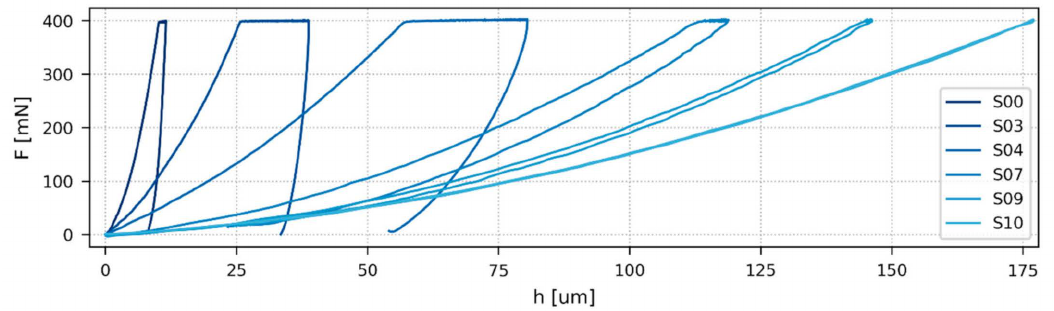
Figure4. F - h curvesofselectedsamplesfromquasi-staticmicroindentationhardnesstesting. Thedarkest colors correspond to the highest T g (cid:48) s (see Table 1 for sample description and T g (cid:48) s).